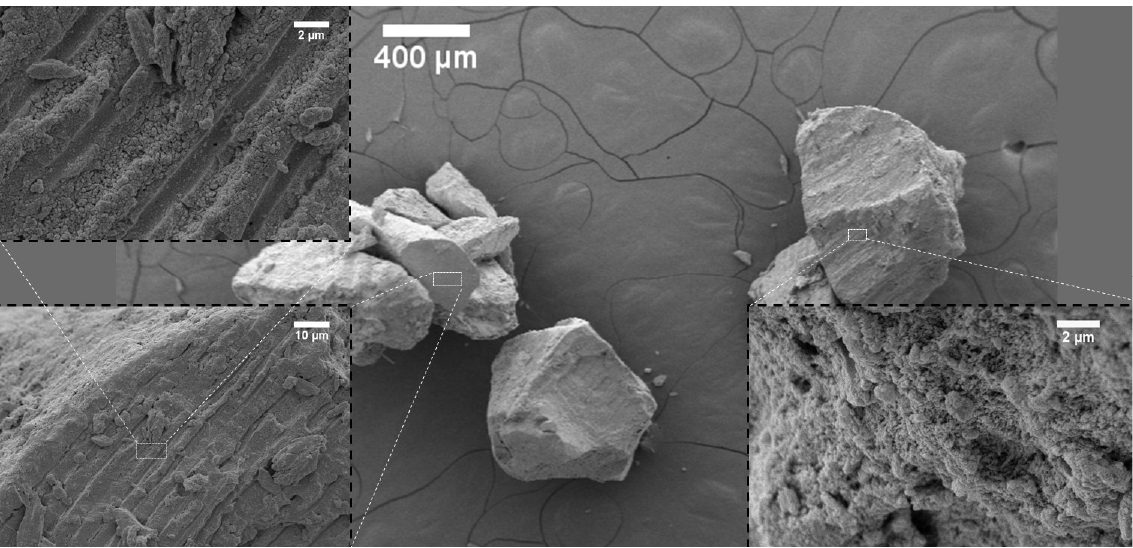
Figure 4. SEM images of Processed-Tooth.